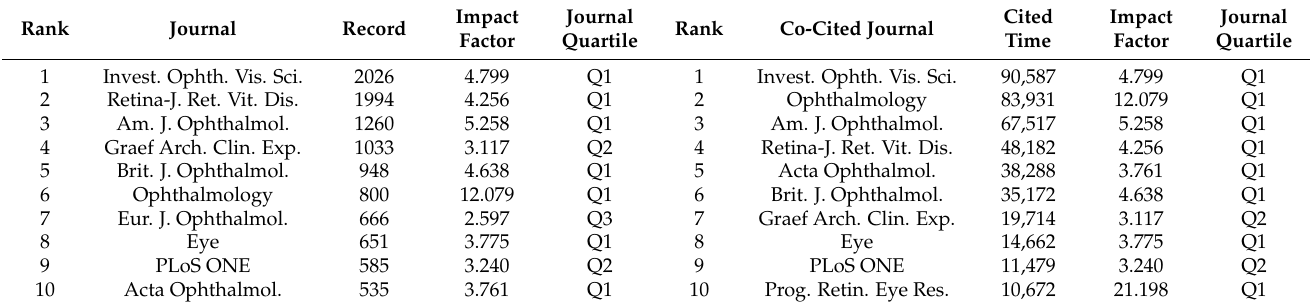
Table 5. The top 10 productive and co-cited